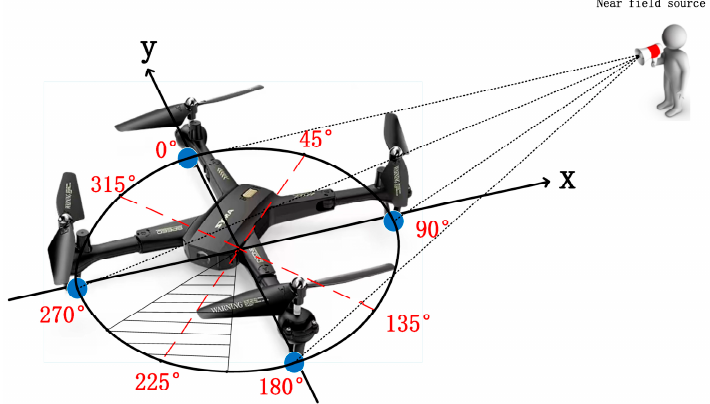
Figure 2. Uniform circular array of UAV and incident wave.